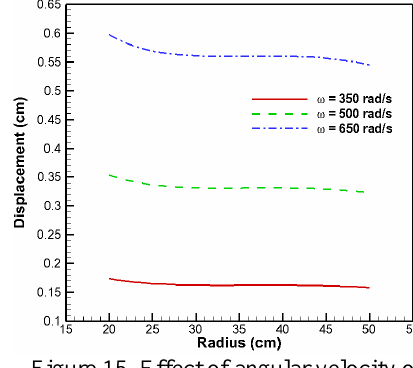
Figure 13. Displacement: 𝑞 = 50 MPa, 𝑇 𝑖 500 𝑜 𝐶, 𝑇 = 0 𝑜 𝐶 , 𝑇 = 250 𝑜 𝐶 and 𝜔 = 350 𝑟𝑒𝑓 𝑟 𝑜 rad/s